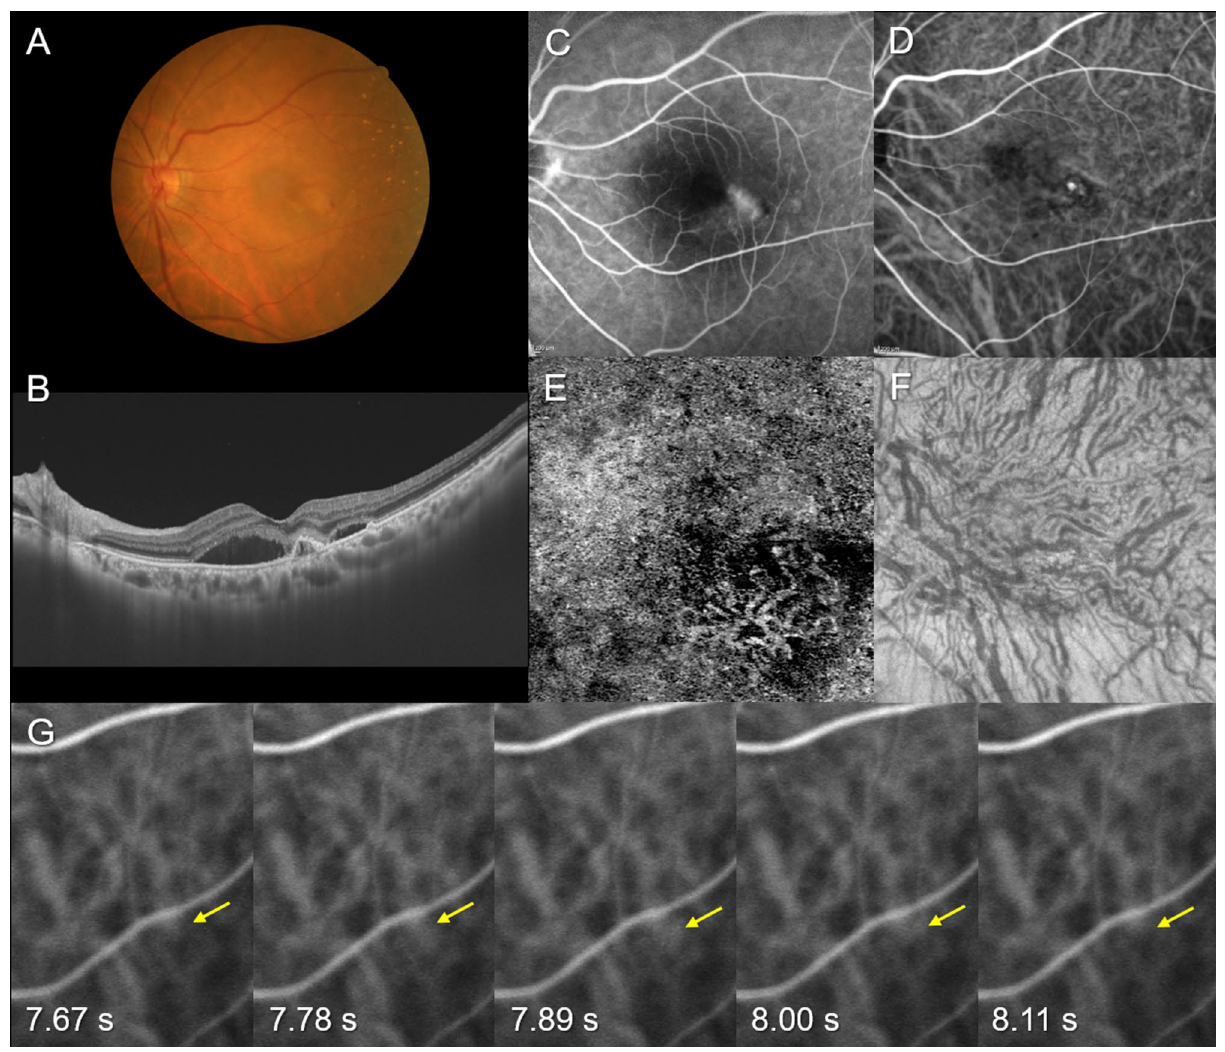
Figure 2. Images of the right eye of an 84-year-old female with polypoidal choroidal vasculopathy. The refraction was − 1.00 diopters. Best-corrected visual acuity was 0.40 logarithm of the minimum angle of resolution unit. ( A ) Color fundus photograph shows retinal pigment epithelium (RPE) detachments accompanied by subretinal hemorrhage and serous retinal detachment (SRD) at the macular area. ( B ) 12 mm horizontal B-mode optical coherence tomography (OCT) images through the fovea show dilated outer choroidal vessels (vortex veins) associated with RPE detachment and SRD. The central choroidal thickness is 281 µm. ( C ) Fluorescein angiography shows window defects and leakage at the macular area. ( D ) Indocyanine green angiography (ICGA) shows dilated choroidal vessels and a polypoidal lesion temporal to the fovea. ( E ) OCT angiography (3 mm × 3 mm) shows network vessels accompanied by a polypoidal lesion between the detached RPE and Bruch’s membrane. ( F ) En face OCT image shows dilated vortex veins in the deep layer of the choroid. Horizontal watershed is lost due to anastomoses between the superior and inferior vortex veins. ( G ) Early phase (7.67–8.11 s after choroidal filling) of ICGA in the inferonasal quadrant shows pulsatile flow in a vortex vein (yellow